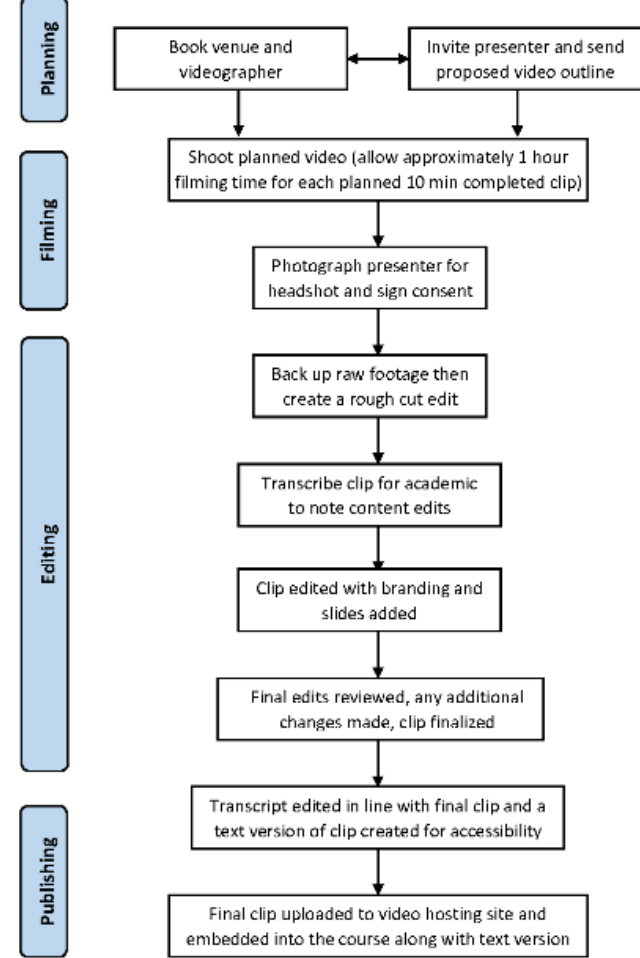
Figure 2. Video production